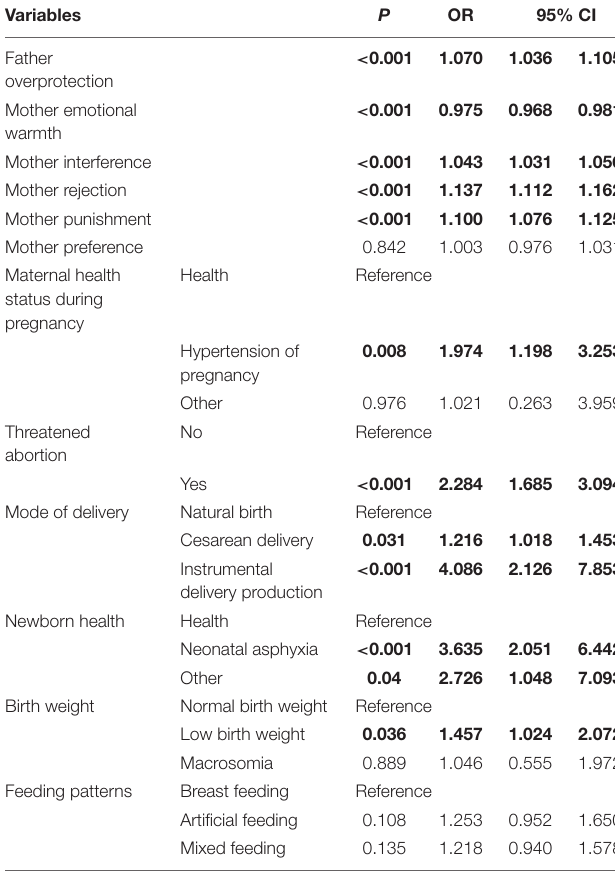
TABLE 2 | Results of univariate analysis (logistic regression analysis) for predicting ADHD in the total study population ( n =